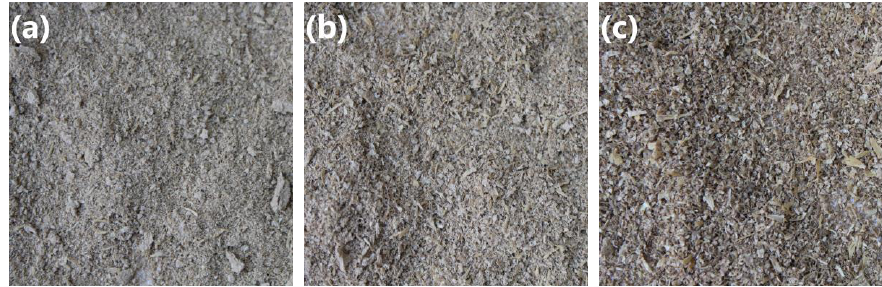
Figure 4. Appearance of BSG extruded at ( a ) 120 ◦ C, ( b ) 180 ◦ C, and ( c ) 240 ◦ C.